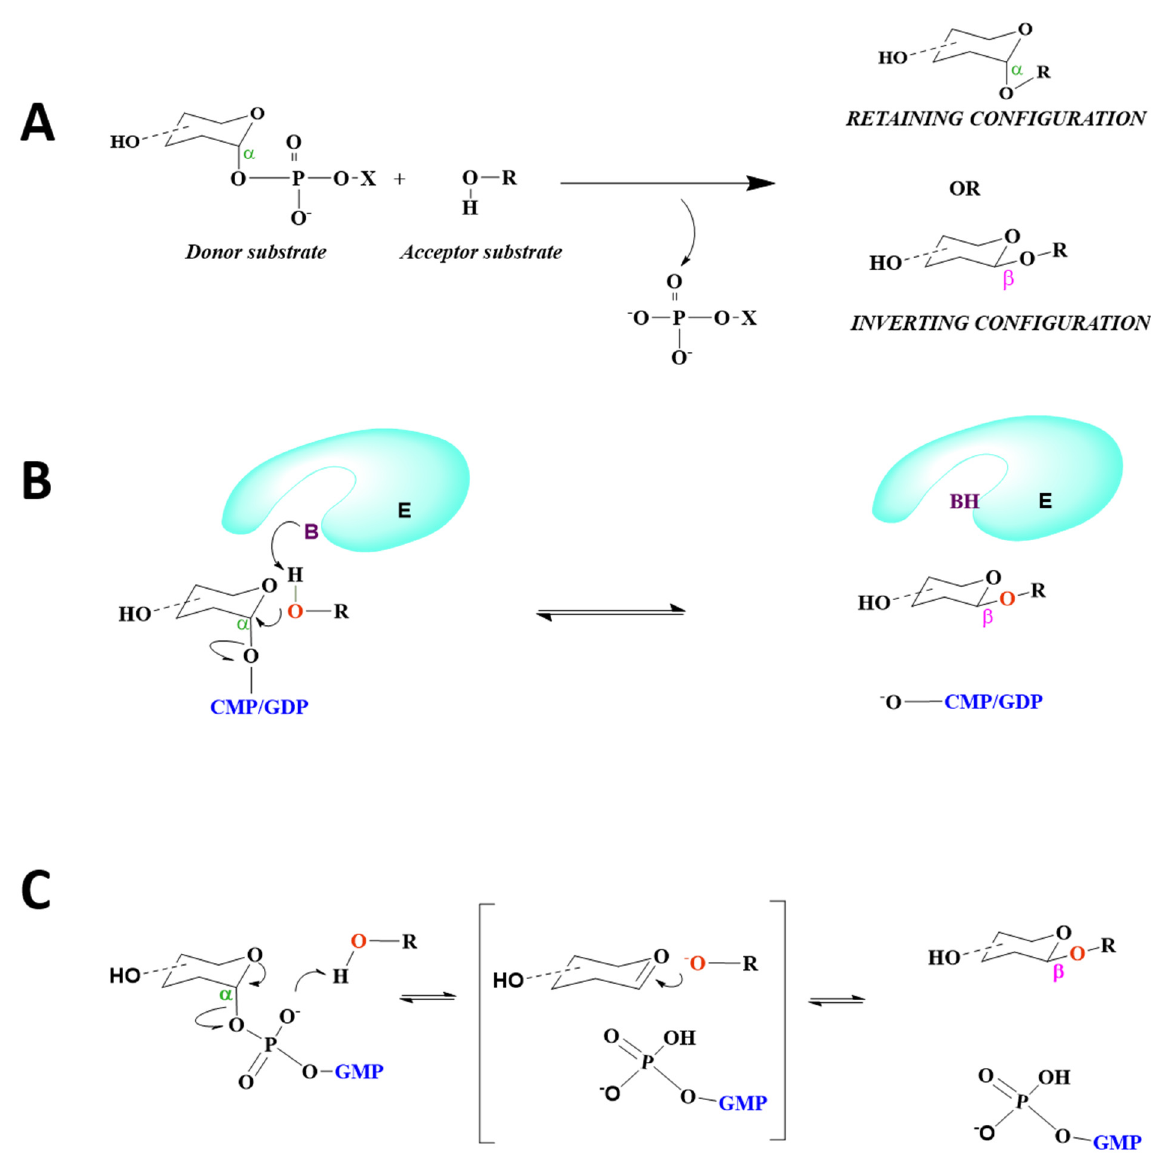
Figure 10. Reaction mechanism of STs and FUTs in mammals. ( A ) GTs catalyze the transfer of a sugar residue from a donor substrate to an acceptor substrate either by retaining or inverting the anomeric stereochemistry with respect to the donor sugar. ( B ) S N 2 inverting mechanism of theGT29 family (e.g., Hs ST3GAL1, Hs ST6GAL1, Hs ST8SIA2, Hs ST8SIA3, Hs ST8SIA4, and FUTs) (e.g., Ce POFUT2, Hs POFUT2, and Hs FUT8). ( C ) S N 1 inverting mechanism for Ce POFUT1 and Mm POFUT1. The cyan E displays the enzyme (ST/FUT); the purple B represents the catalytic base, which deprotonates the acceptor nucleophile; and the red O indicates the nucleophilic oxygen of the acceptor substrate. CMP, GMP, and GDP (blue) are cytidine monophosphate, guanosine monophosphate, and guanosine diphosphate, respectively.